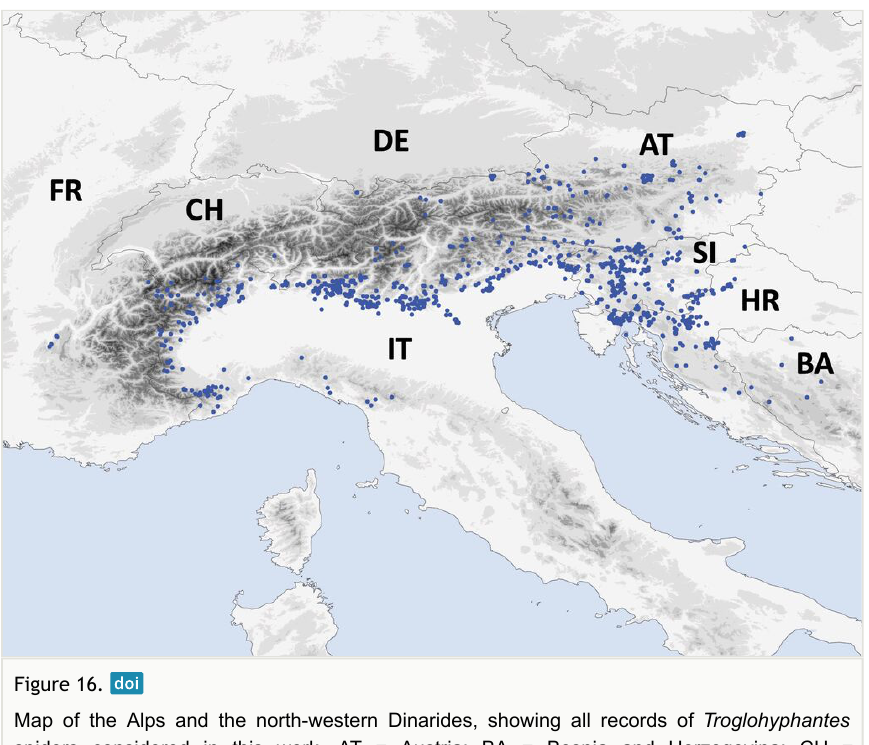
according to the IUCN Red List Criteria (IUCN 2001, IUCN 2012). In most cases (62 out of 66 species), the data in hand allowed us to calculate the Extent Of Occurrence (EOO) and the Area Of Occupancy (AOO).